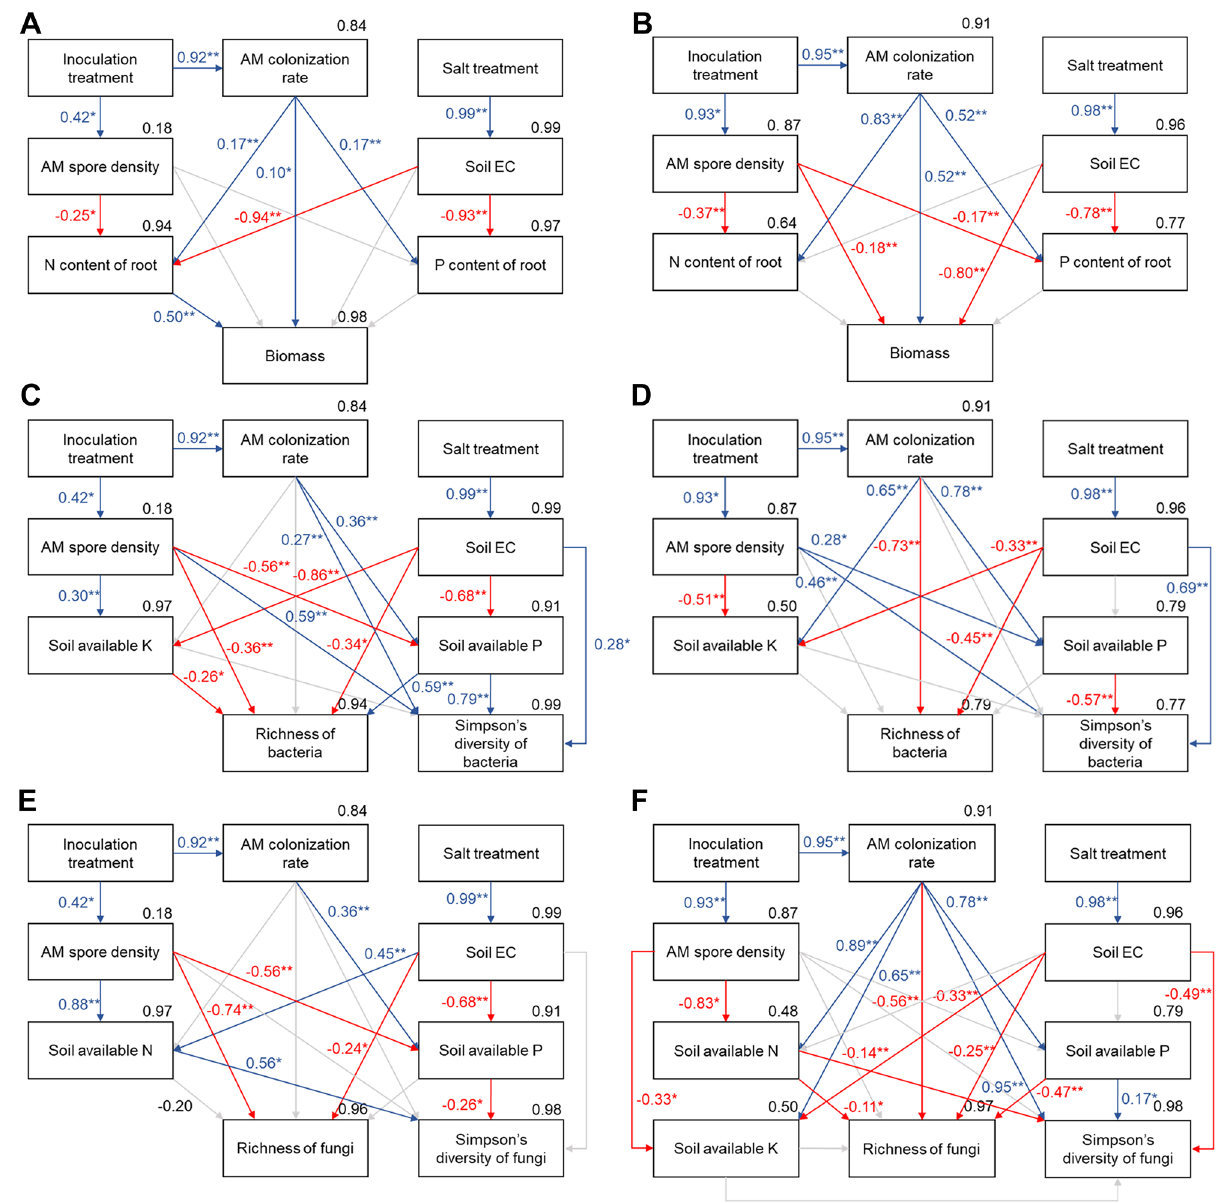
Figure 5. Structural equation model of casual relationships based on the result of Mantel statistics. A , B Model for biomass accumulation data of female and male seedlings; C , D Model for bacterial richness and Simpson diversity index data of female and male seedlings; E , F Model for fungal richness and Simpson diversity index data of female and male seedlings. Note : The number in the top right corner of each of the soil or microbial parameter boxes is the squared-multiple correlation, and the number on each line between these parameter boxes is the standardized regression-weight (*: significant at P < 0.05; **: significant at P < 0.01). Red solid lines indicate that the standardized regression weights are negative, blue solid lines indicate that the standardized regression weights are positive, and gray dashed lines indicate that the standardized regression weights are not significant ( P ≥ 0.05) and thus their statistics are not